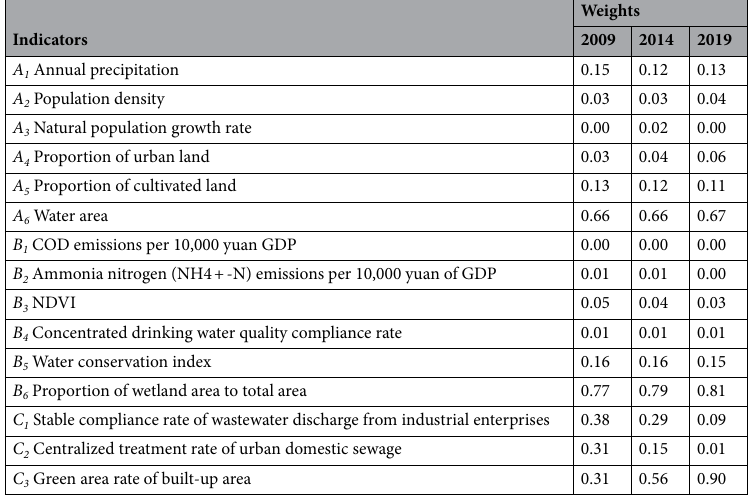
Table 3. Water ecological security index weight.